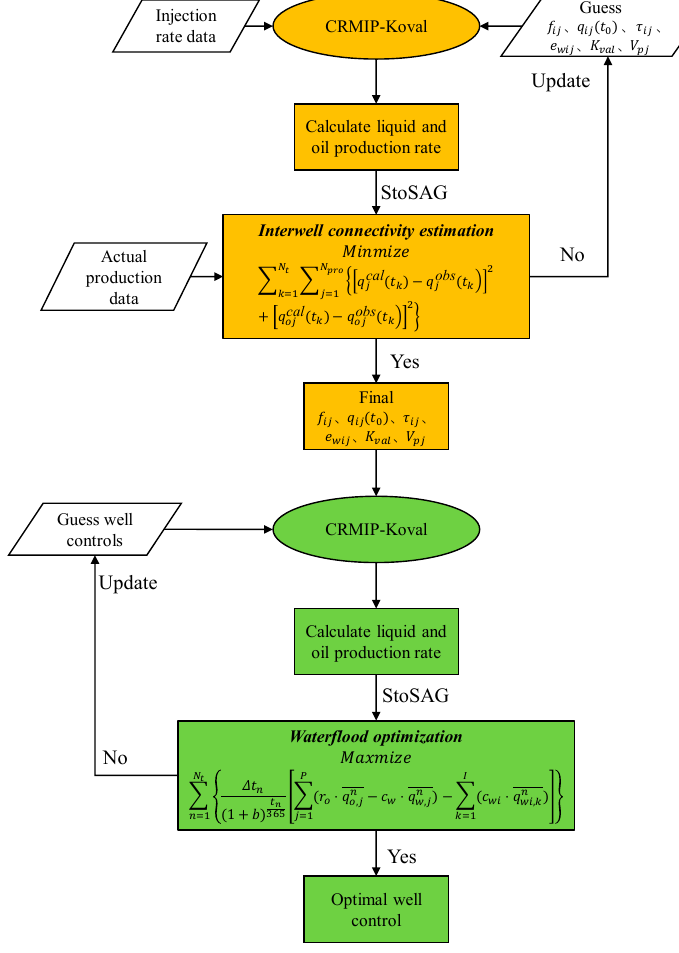
Figure 2. Workflow for inter-well connectivity estimation and waterflood optimization.